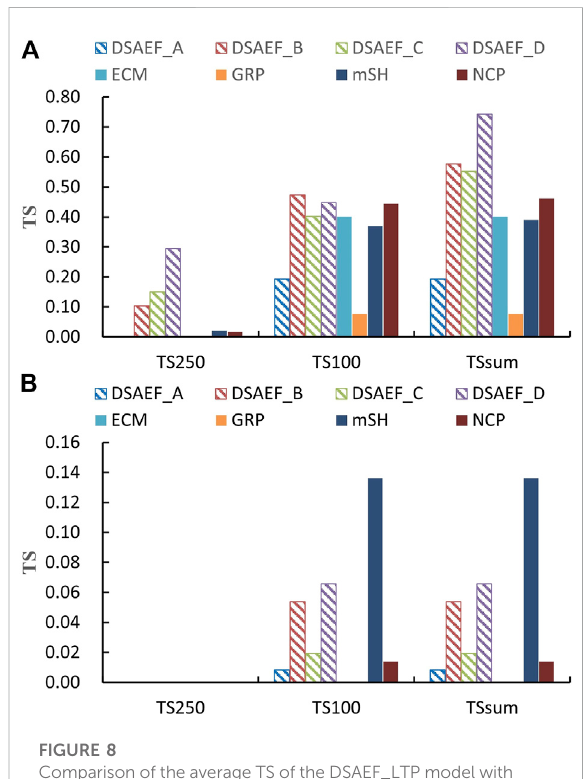
FIGURE 8 Comparison of the average TS of the DSAEF_LTP model with four numerical models (ECM, GRP, NCP, mSH) in independent forecast experiments in Fujian Province. (A) The top four TCs with higher TSsum, (B) the bottom four TCs with lower TSsum.